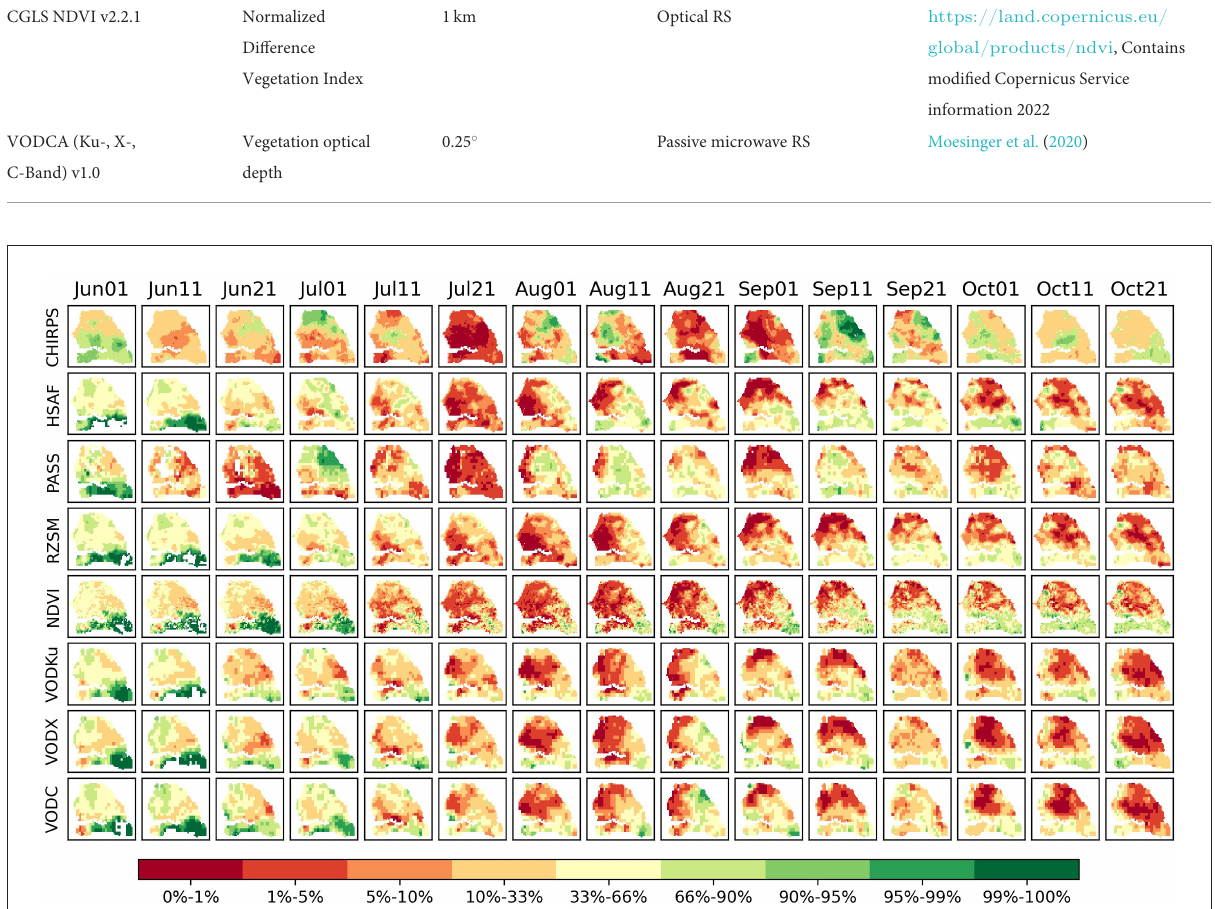
FIGURE2 Spatio-temporal development of the 2014 drought in Senegal represented by anomaly percentiles in all datasets.